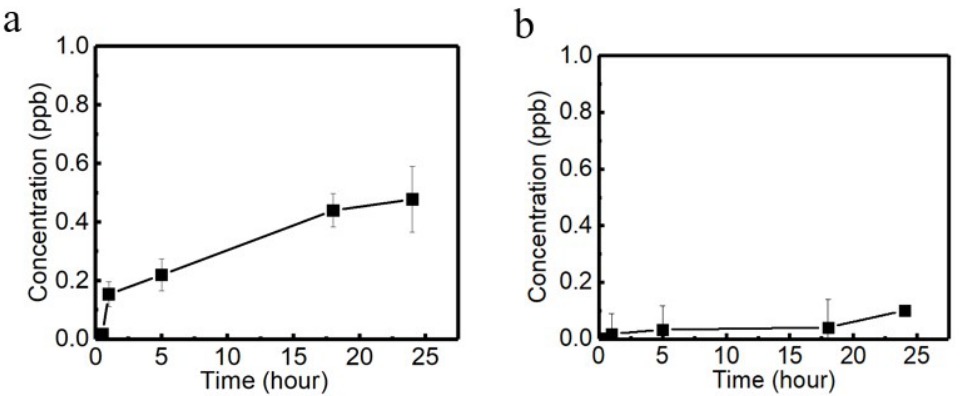
Figure 3. The concentration of Ag + outside the dialysis tube as a function of time for AgNCs ( a ) and MOF-AgNCs ( b ) during the dialysis process.